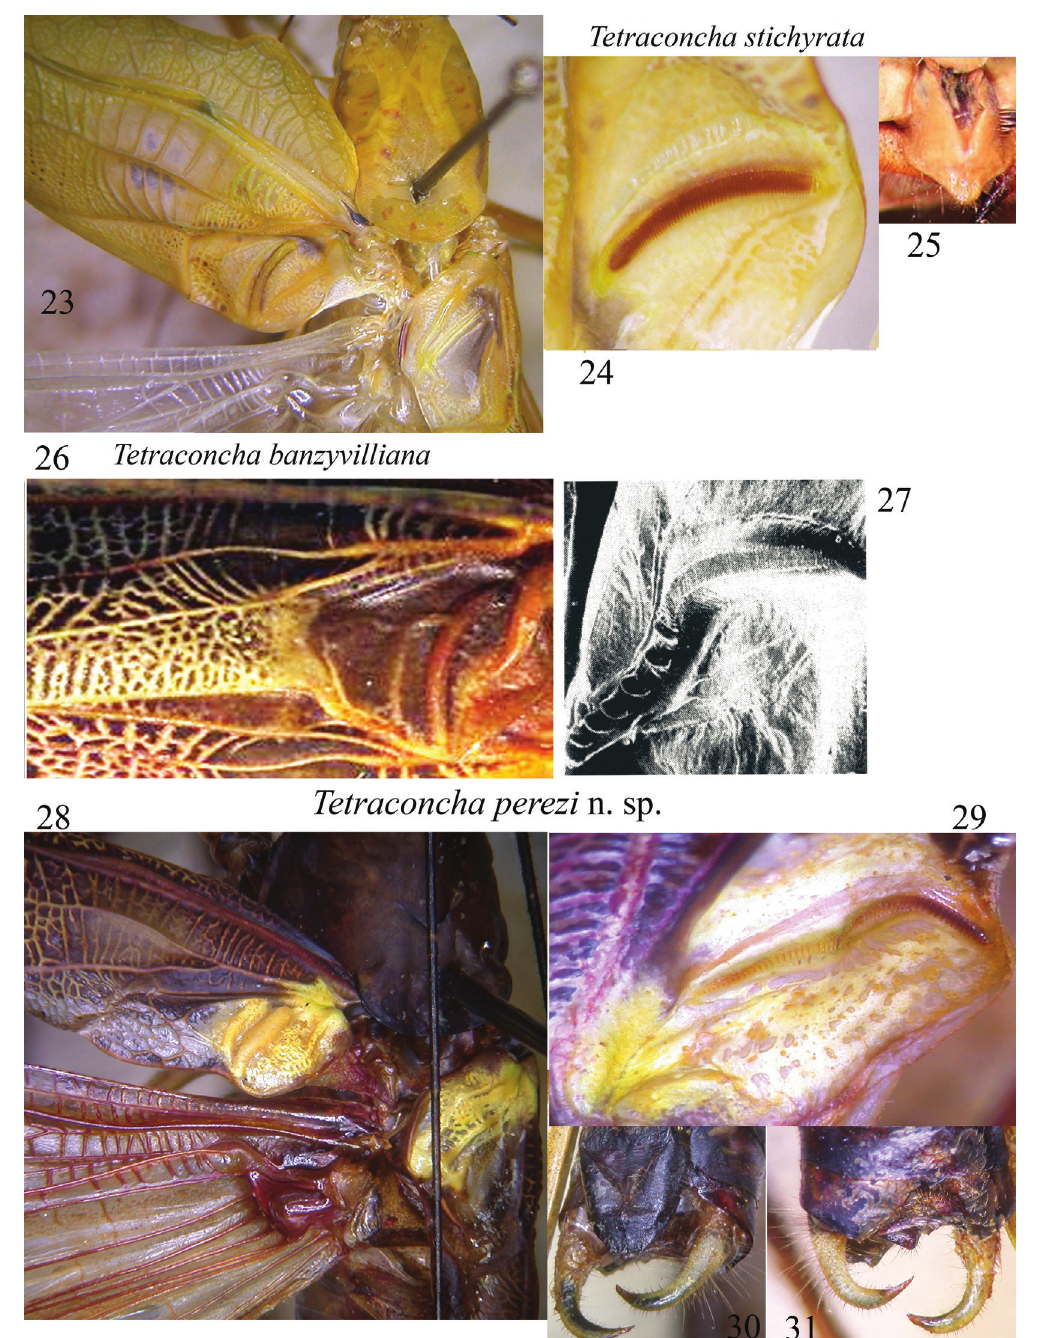
Figs 23–31. Tetraconcha stichyrata male (Ivory Coast, Taï Nat. Park): 23. Stridulatory area; 24. Stridulatory file below the left tegmen; 25. Subgenital plate in ventral view. Tetraconcha banzyvilliana male (Cameroon): 26. Stridulatory area; 27. Stridulatory file below the left tegmen. Tetraconcha perezi sp. n. holotype male (Central African Republic, N’Doki): 28. Stridulatory area; 29. Stridulatory file below the left tegmen; 30. Subgenital plate in ventral view; 31. Cerci in dorsal view. Fig. 26 after Orthoptera Species File, Fig. 27 after Leroy